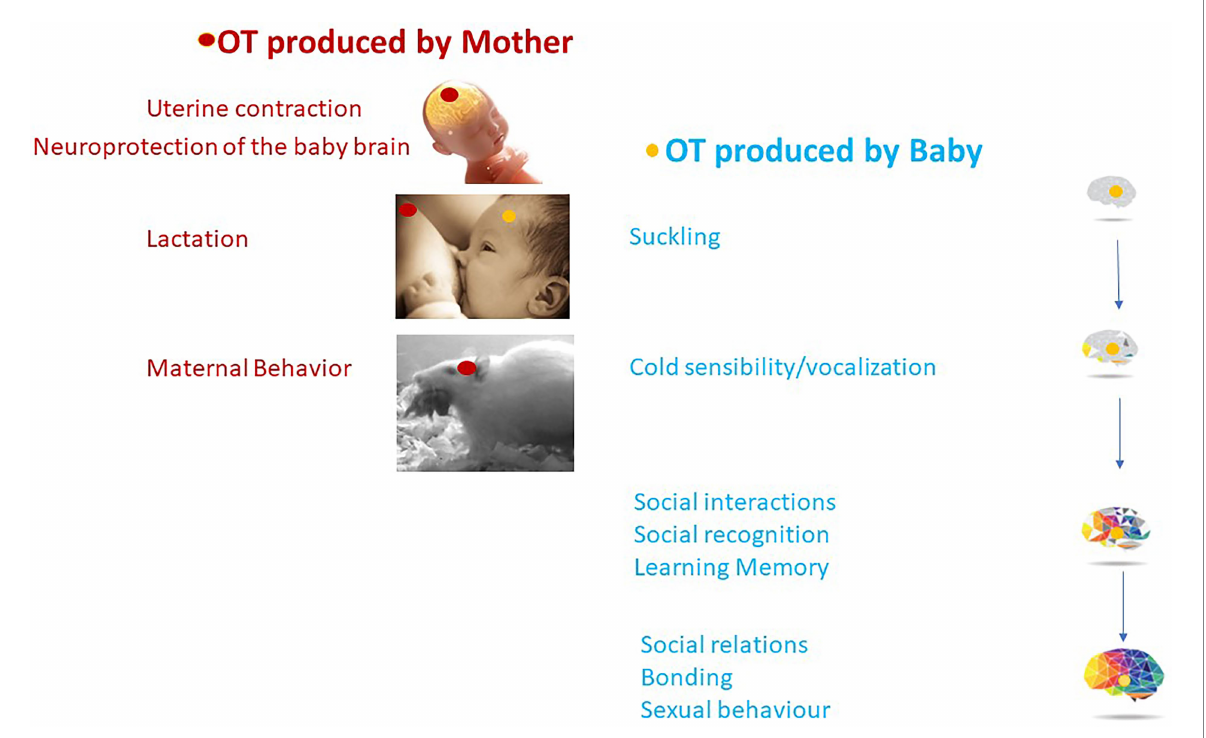
FIGURE 5 OT plays a concerted action between OT produced by the mother (in red) and OT produced by the baby (in blue) with long-lasting effects on social behavior and brain